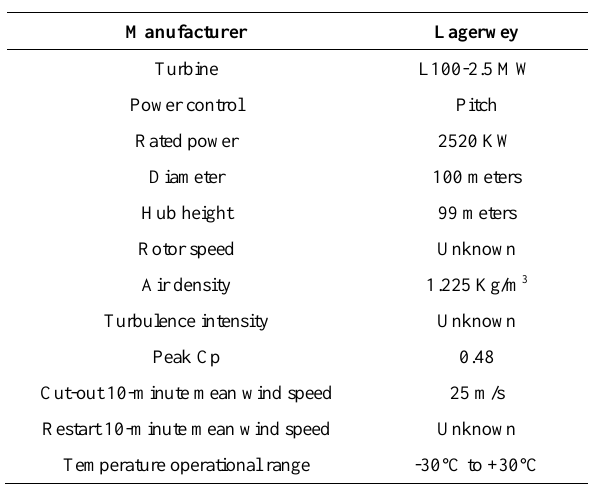
Table 3. The technical specifications of Lagerwey L100-2.5 MW turbine